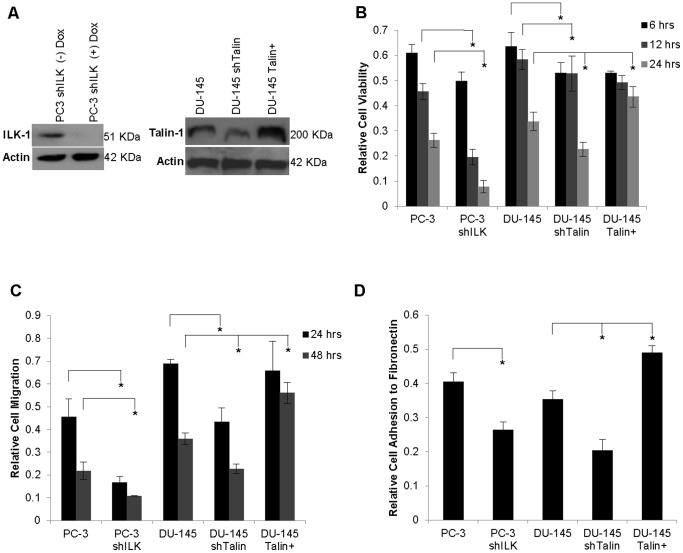
ILK and talin mediate DZ-50 action on prostate cancer cell death and migration.Panel A, right, Western blot revealing that shILK transfectant PC-3 cells exhibit total loss of ILK-1 protein expression relative to vector control cells upon induction with doxycycline (48 hrs). On the left, DU-145 cells in which talin has been silence (shTalin) or overexpressed (Talin+), exhibit significant reduction or marked overexpression of talin protein levels respectively, relative to parental DU-145 cells. Panel B, DZ-50 treatment leads to a significant decrease in prostate cancer cell viability in a time-dependent fashion. Loss of ILK1 enhances the DZ-50 induced loss of cell viability; in contrast talin overexpression confers resistance to DZ-50 induced cell death. Panel C, DZ-50 significantly reduces prostate cancer cell migration. Loss of talin results in a significant reduction of prostate cancer cell migration compared to parental control DU-145 cells. In response to DZ-50, talin overexpression restores cell migratory ability to the levels of untreated cells. Panel D, Functional loss of ILK in PC-3 prostate cancer cells and loss talin in DU-145 cells significantly impairs the ability of the respective prostate cancer cells to adhere to fibronectin (ECM). Talin overexpression markedly enhances prostate cancer cell adhesion to fibronectin, compared to parental DU-145 and DU-145 shTalin cells. Statistical significance was set at *p<0.05.